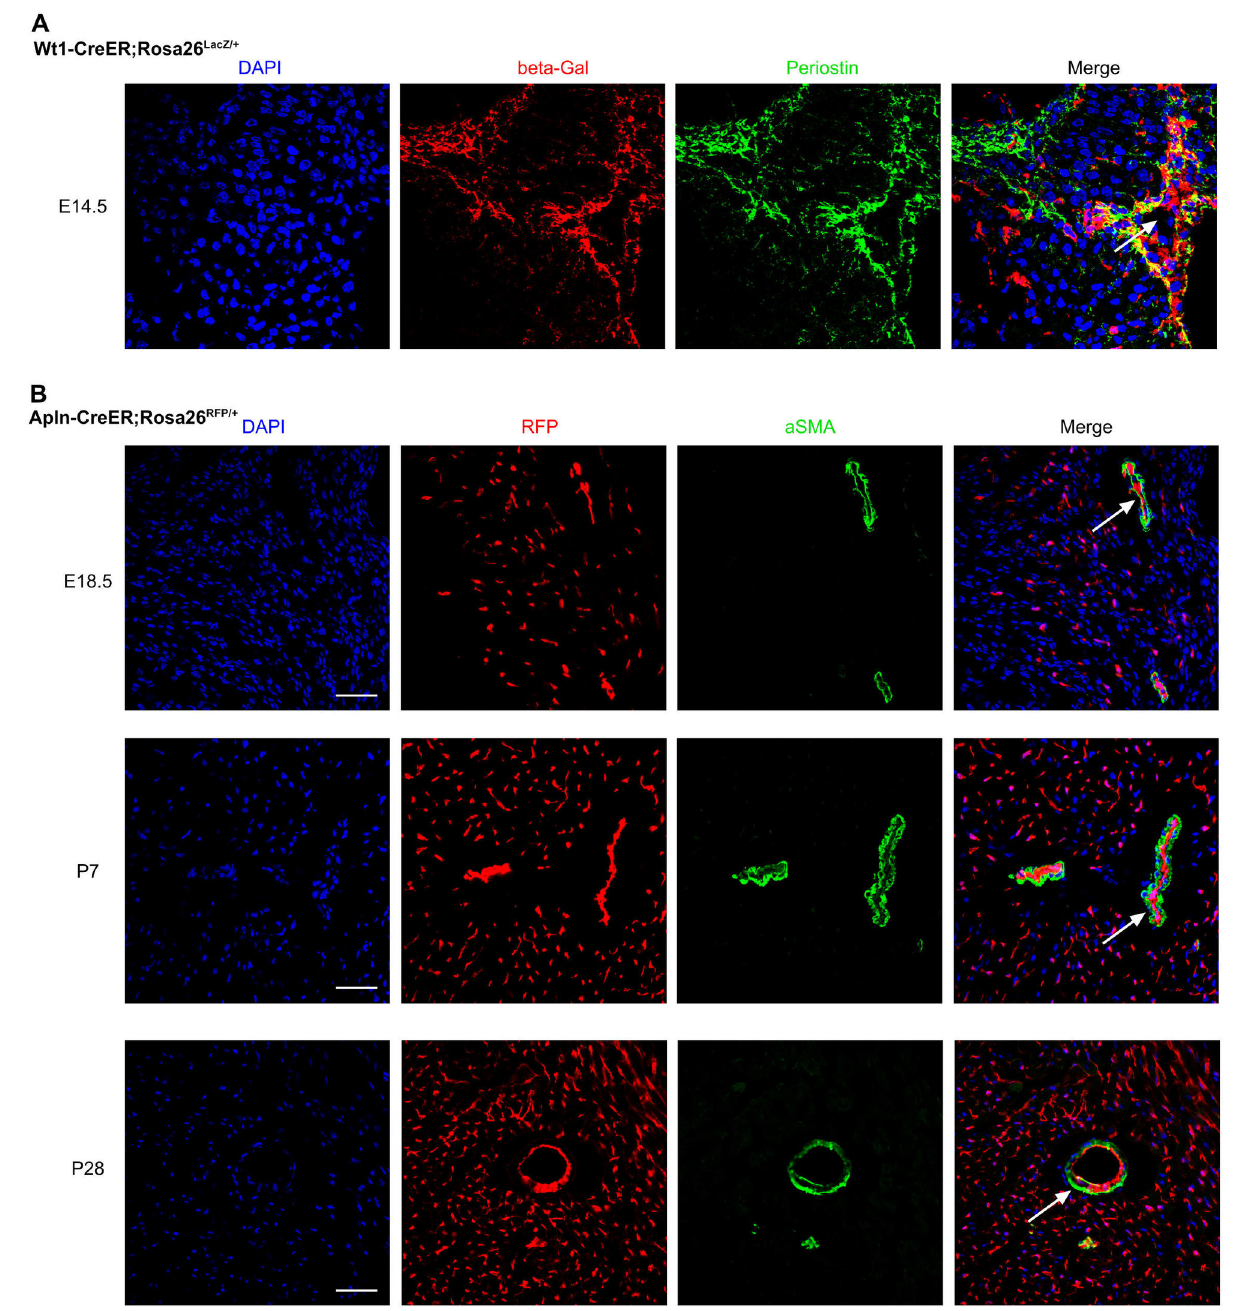
Figure 3. Apln+ endothelial cells contribute to mature coronary arteries. ( A ) Immunostaining of genetic marker bet-Gal and extracellular marker periostin shows EPDCs were located around coronary vessels (white arrows). ( B ) Immunostaining of genetic marker RFP and smooth muscle cell marker (aSMA) on AplnCreERT2/+;Rosa26RFP/+ heart sections. White bar = 50 um.